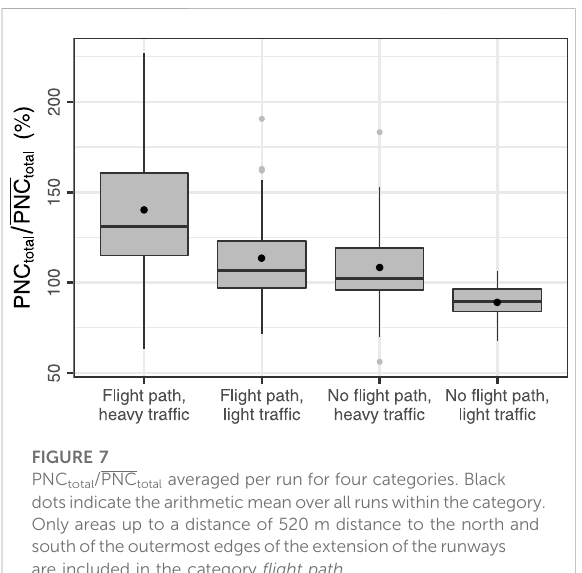
FIGURE 8 Comparison of track points located downwind (dark gray boxes) and those not downwind (light gray boxes) of the runway. PNC total /PNC total averaged per run for the four categories. Only areas up to a distance of 520 m to the north and south of the outermost edges of the extension of the runways are included in the category fl ight path